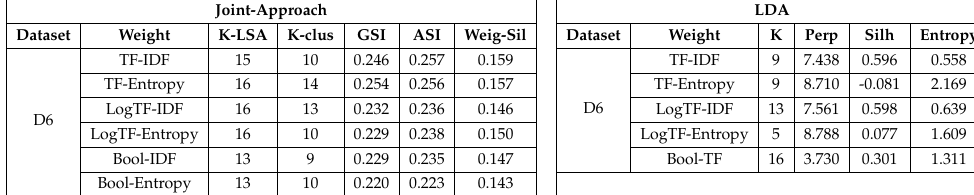
Table 10. Experimental results for D6.